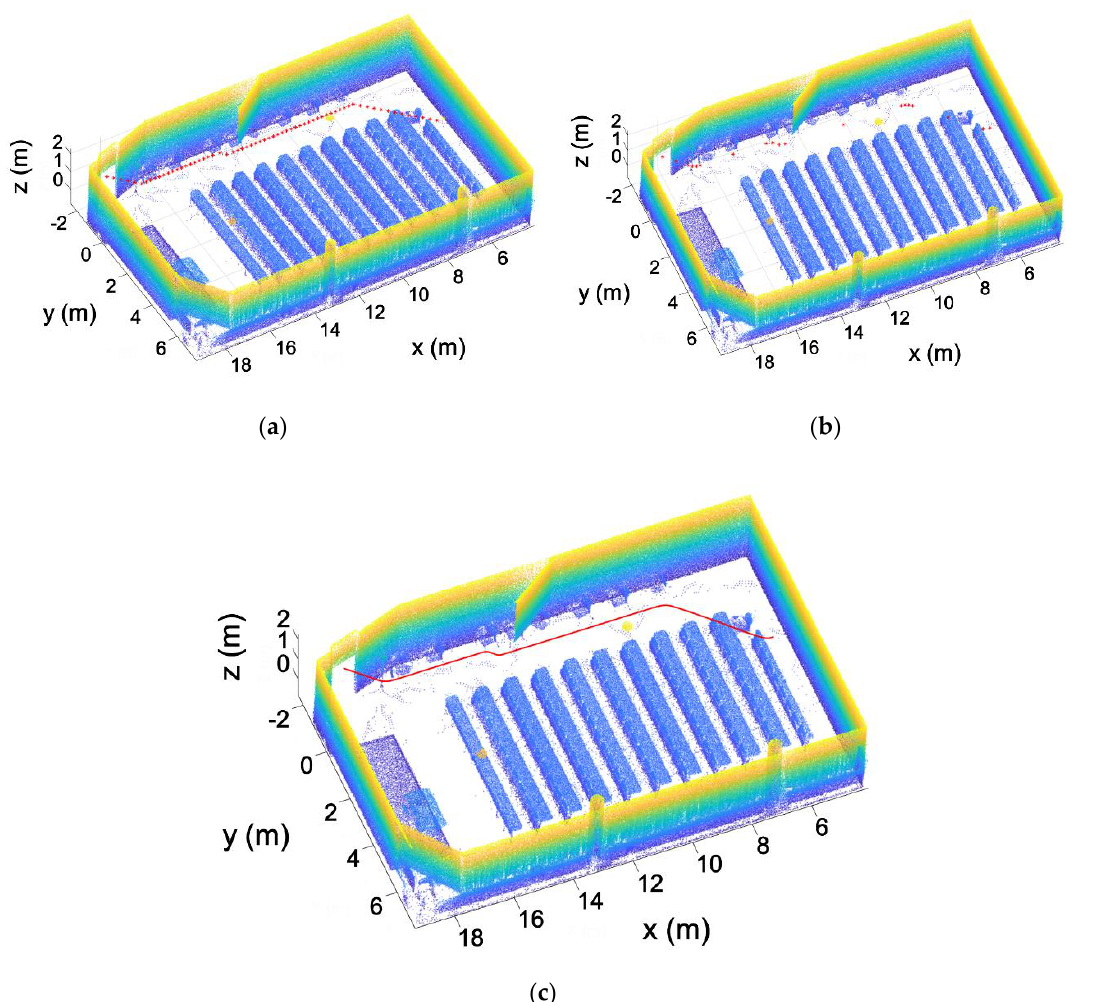
Figure 16. Path smoothing (red: Waypoints). ( a ) Initial path. ( b ) Path smoothed and simplified. ( c ) Final path after smoothing.